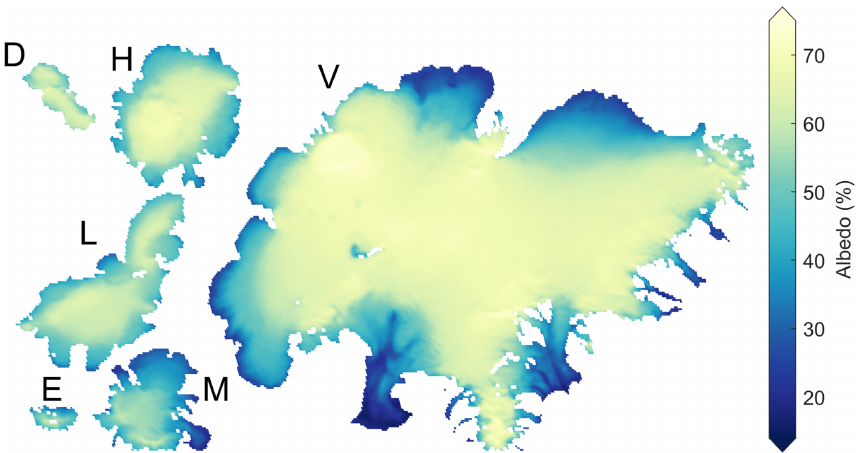
Figure 4. Spatial patterns of mean albedo for the period 2000–2019 (MJJA). D: Drangajökull; H: Hofsjökull; V: Vatnajökull; L: Langjökull; E: Eyjafjallajökull; M: